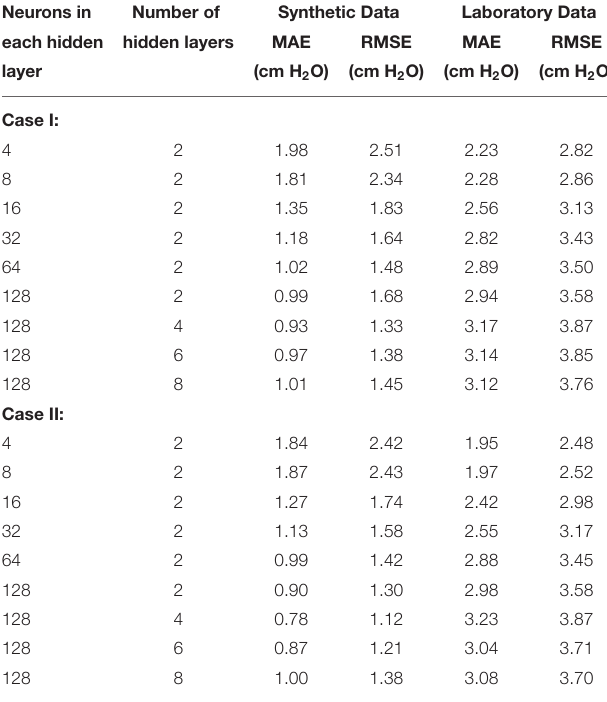
TABLE 3 | MAE and RMSE between the estimated P s with the proposed NN regression model and the reference measures from synthetic and laboratory test